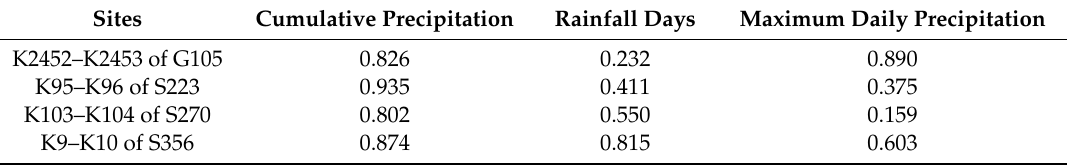
Figure 7. Relationship between the SPI changes and the impact factors: ( a ) K2452–K2453 of G105; ( b ) K95–K96 of S223; ( c ) K103–K104 of S270; and ( d ) K9–K10 of S356. Table 3. Pearson Correlations between the SPI changes and impact factors.